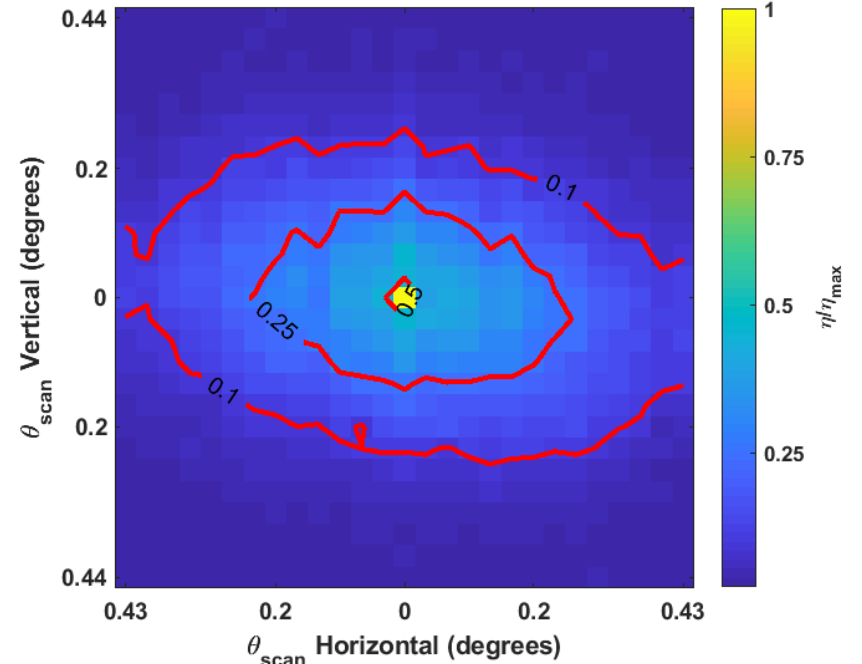
Figure 5. Experimental enhancement of displaced spot as a two-dimensional function of displacement size after a circular shift of the SLM phase map, of focal plane system shown in Figure 1 zinc oxide paint, on glass. Results were averaged over five trials. The maximum value of η prior to normalization was 80 ±